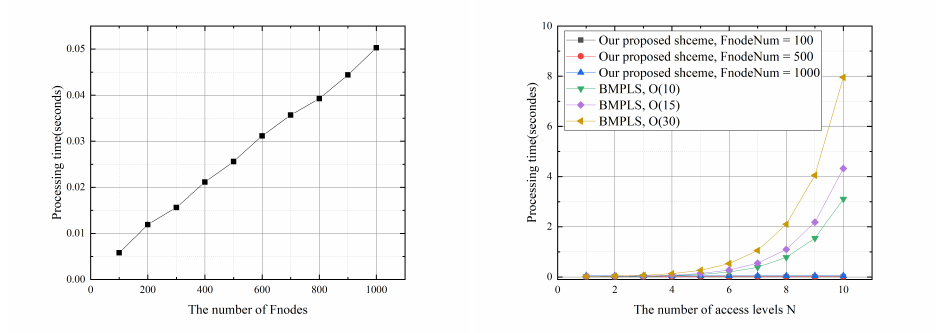
Figure 8. Computation overhead of LP in the initialization